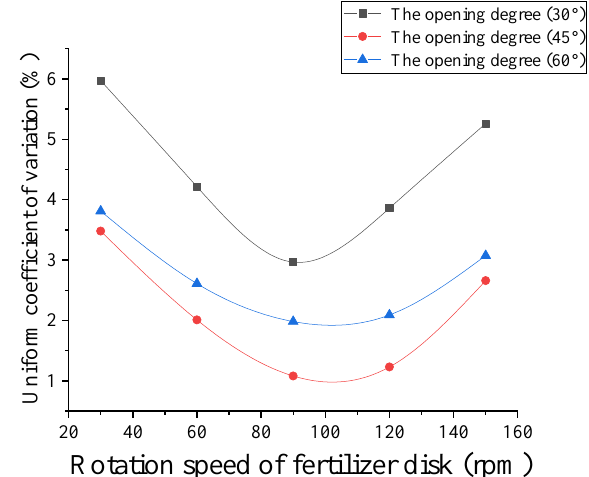
Figure 13. Analysis of coefficient of variation results of bench test.